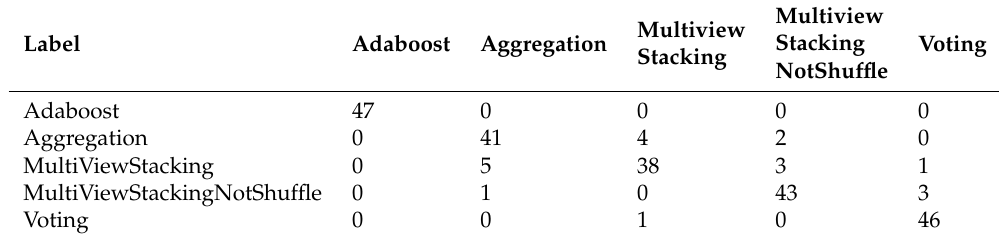
Table 13. Confusion matrix of RFC based on the Statistical signature data set.